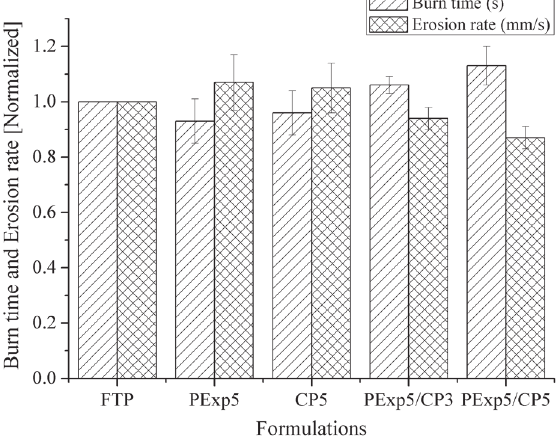
Figure 3 - Burn time and erosion rate for the formulations studied.